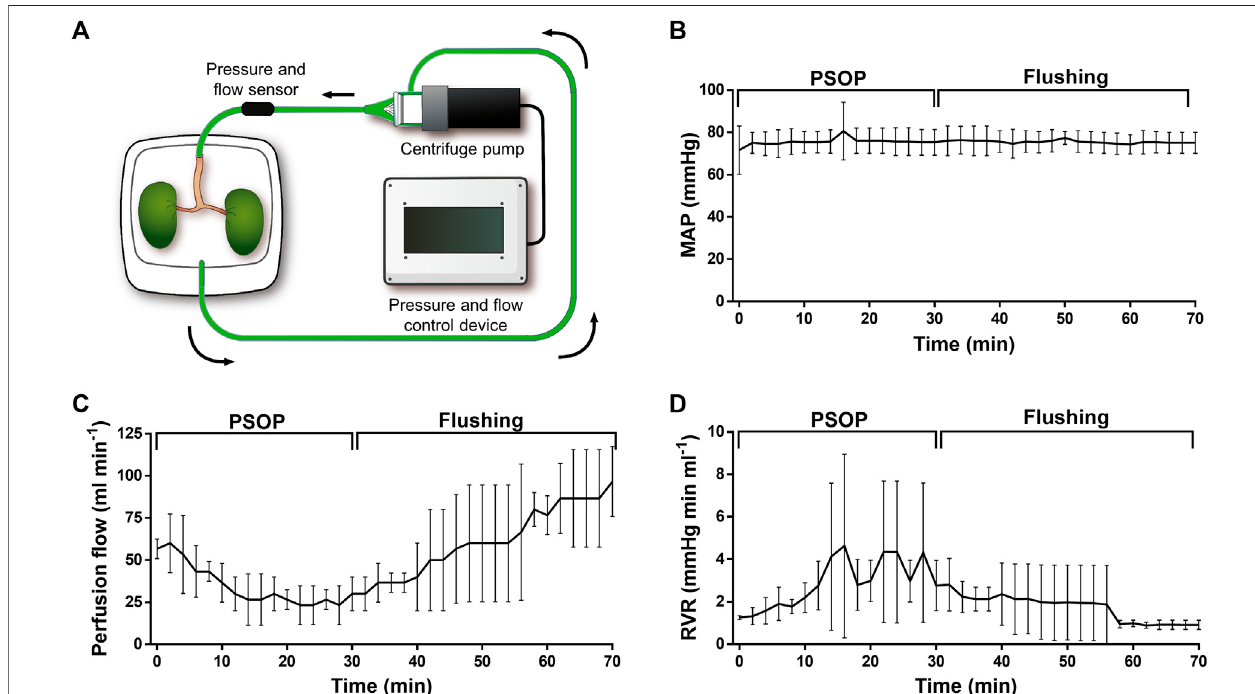
FIGURE6| Dynamicperfusionofisolatedporcinekidneys.Schematicrepresentationofthe exvivo perfusionsystem,containingapressure- fl owcontrollingdevice, a centrifuge pump, and a container for the isolated organs (A) . Vascular parameters were measured during the photosynthetic perfusion and the subsequent fl ushing step. Mean arterial pressure (MAP) was set to 70 – 80 mmHg remaining stable during the entire procedure (B) . Perfusion fl ow decreased during the PSOP perfusion (C) , while renal vascular resistance (RVR) increased, recovering during the fl ushing step (D) . Data are expressed as mean ± SEM; N (cid:2) 3 in (B – D) .